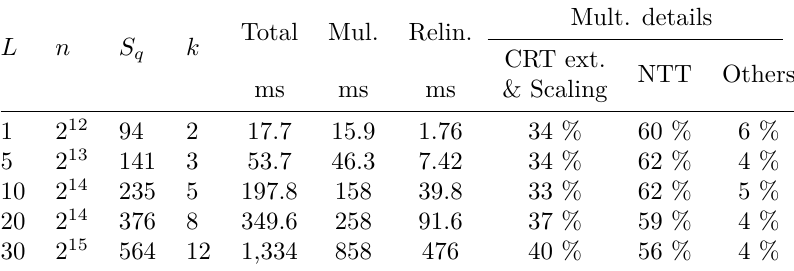
Table 1: Profiling of BFV ciphertext multiplication and relinearization by Halevi et al. reproduced from [HPS18]. Single-threaded mode, Linux CentOS, Intel Core i7-3770 CPU 4 cores at 3.40GHz with 16 GB of RAM; plaintext space t = 2, s ≈ 47, security λ >